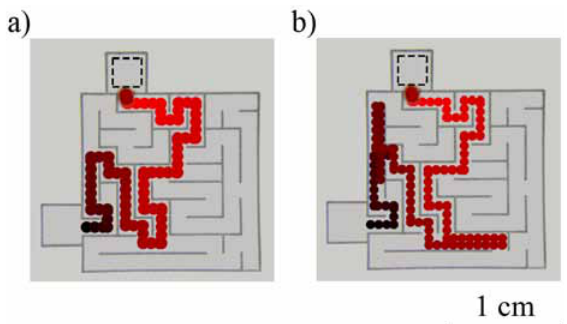
Figure 1. Autonomous motion of droplets utilizing artificial chemotaxis in a pH gradient in a maze. Position of the gel soaked with HCl at the maze’s entrance is indicated by dashed-line boxes. Reprinted with permission from Ref. 46. Copyright 2010 American Chemical